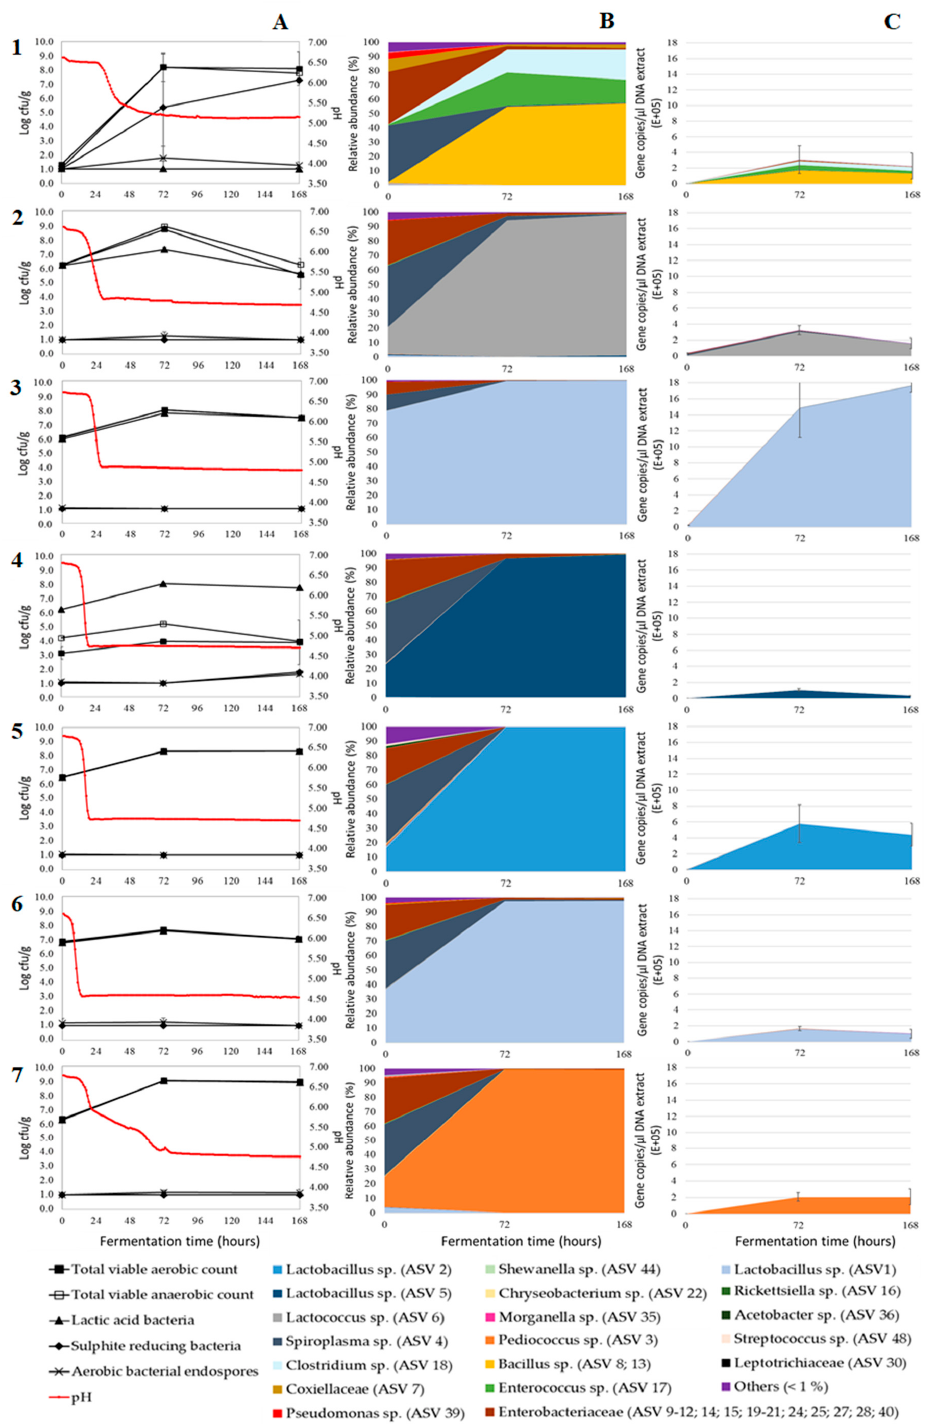
Figure 1. Microbial counts and pH ( A ), relative abundance in the bacterial community ( B ), and estimated absolute abundances (EAA) ( C ) during fermentation of pastes without sodium nitrite prepared from mealworms of the first production batch, and without starter (control experiment) ( 1 ) or inoculated with starter Lactococcus lactis ( 2 ), Lactobacillus curvatus ( 3 ), L. farciminis ( 4 ), L. plantarum ( 5 ), L. sakei ( 6 ), or Pediococcus acidilactici ( 7 ). The microbial counts and values of relative abundance and EAA are the mean of analyses performed on three replicate samples. Error bars represent the standard deviation. Only amplicon sequence variants (ASVs) represented by an average relative abundance of more than 1% of the sequences in any sample are shown. Other ASVs are grouped together in “others ( <